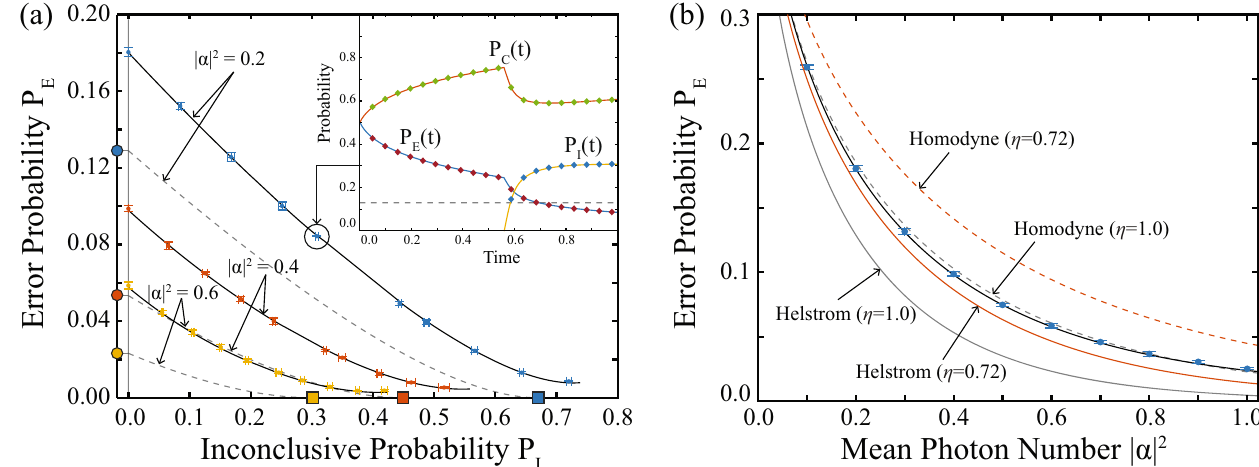
Fig. 2 Experimental Results. a Experimental results for the optimal inconclusive measurement for ∣ α ∣ 2 = 0.2, 0.4, and 0.6, in blue, orange, and yellow, respectively. Each point corresponds to the measured values of f P exp ð 1 Þ ; P exp ð 1 Þg and the error bars represent one standard deviation I E from fi ve sets of 5 × 10 4 individual experiments each. The solid lines show the expected results and the dashed gray lines show the ideal performance for each ∣ α ∣ 2 . The colored circles and squares on the y -axis and x -axis show the optimal P E and P I for ideal MESD and USD, = 0.31. b Experimental results (blue points) of an optimal MESD respectively. Inset (i): evolution of P exp , P exp , and P exp for ∣ α ∣ 2 = 0.2 and and P exp E I I C measurement, the Dolinar receiver, for phase coherent states f ± α j ig . The gray and red solid lines show the Helstrom bound for η = 1.0 and η = 0.72, respectively, and the dashed lines show the corresponding error for a homodyne